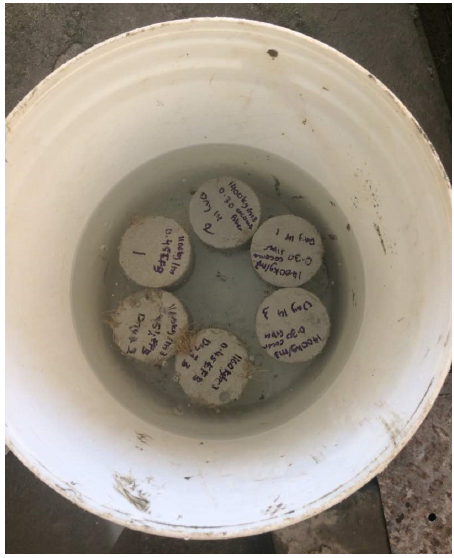
Figure 6. Water absorption test.